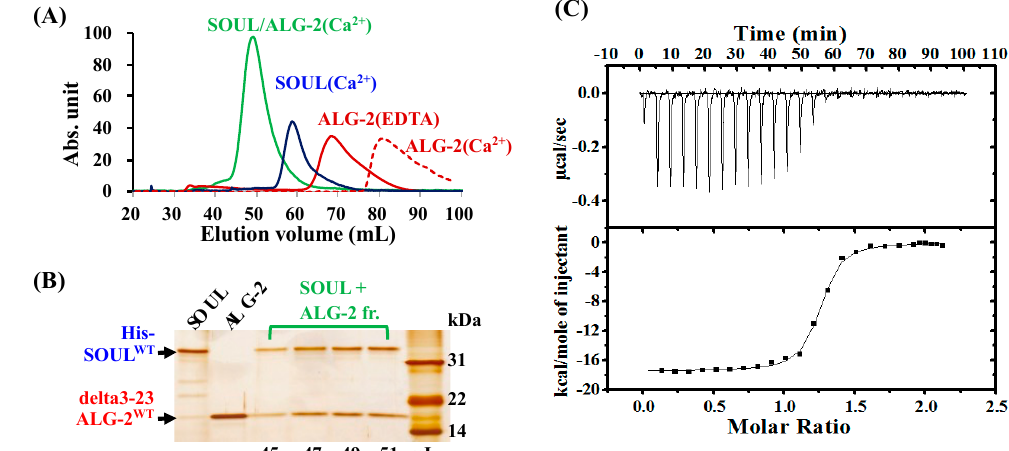
Figure 3. Interaction between His-SOUL WT and delta2-23 ALG-2 WT . ( A ) Tetrameric complex formation of His-SOUL WT with delta2-23 ALG-2 WT in solution. Each protein sample (5 µ M) was analyzed on a Sephacryl-S-200 HR column. Elution profiles of 5 µ M of His-SOUL WT (blue line), 5 µ M of delta3-23ALG-2 WT (dotted red line), the mixture (green line) of 5 µ M of each protein in the presence of 20 µ M Ca 2+ , or delta3-23ALG-2 WT in the presence of 2 mM EDTA (red line). ( B ) Sliver staining after SDS-PAGE of fractions eluted from the gel-filtration of the mixture. ( C ) ITC measurements for the interactions between SOUL WT and delta3-23 ALG-2 WT . Typical calorimetric titrations (upper panel) and the resulting integrated binding isotherm (lower panel) at 25 ◦ C and pH 7.5 in the presence of 15 µ M Ca 2+ . 5 µ L aliquots of 130 µ M His-SOUL WT were injected into 5 µ M delta3-23ALG2 WT . After subtracting the heat of ligand dilution, the solid line connecting the integrated data points was obtained from a one-set-of-sites model fitting using a nonlinear least-squares method.